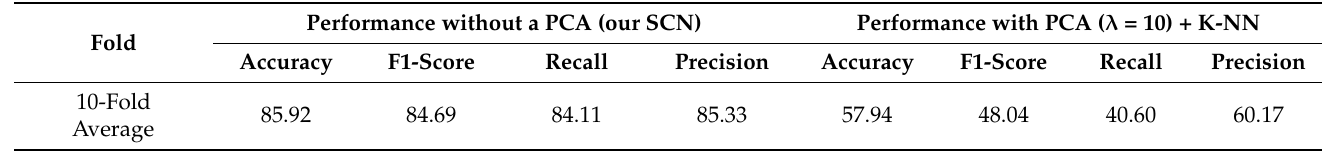
Table 7. Performance comparisons of our proposed SCN using a PCA and a K-NN (unit: %). Performance without a PCA (our Fold